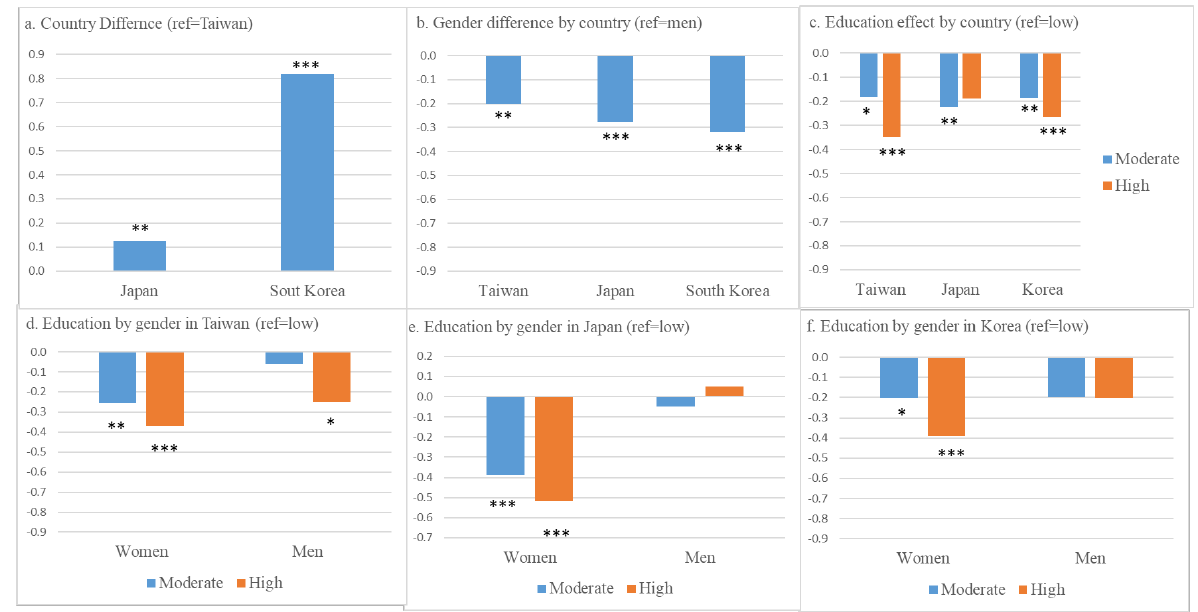
Figure 1. Gender and education effects on attitudes toward women political leadership in three Asian countries, the WVS. Note: * p < 0.05; *** p < 0.001. Figure presents average marginal effects of each factor based on logistic regression models. Positive estimates indicate higher likelihood of supporting traditional attitudes that favor men over women in political leadership. ( a ) shows the main effect of country; ( b ) shows the main effect of gender in each country; ( c ) shows the main effect of education in each country; ( d ) shows the interaction between education and gender in Taiwan; ( e ) shows the interaction between education and gender in Japan; ( f ) shows the interaction between education and gender in Korea.